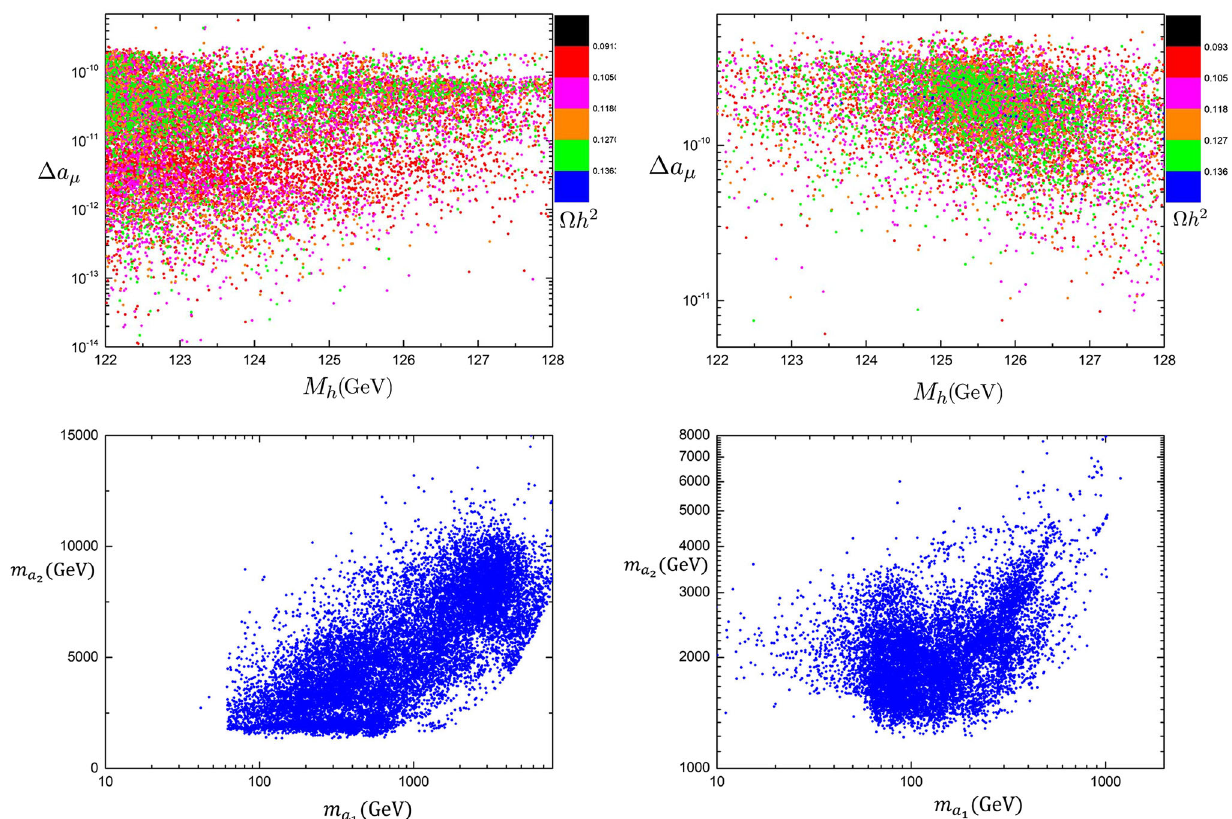
Fig. 6 The upper panels show the SUSY contributions to the muon anomalous magnetic moment (cid:12) a μ for Type A (left) and Type B (right). The lower panels show the corresponding masses of the lightest CP-